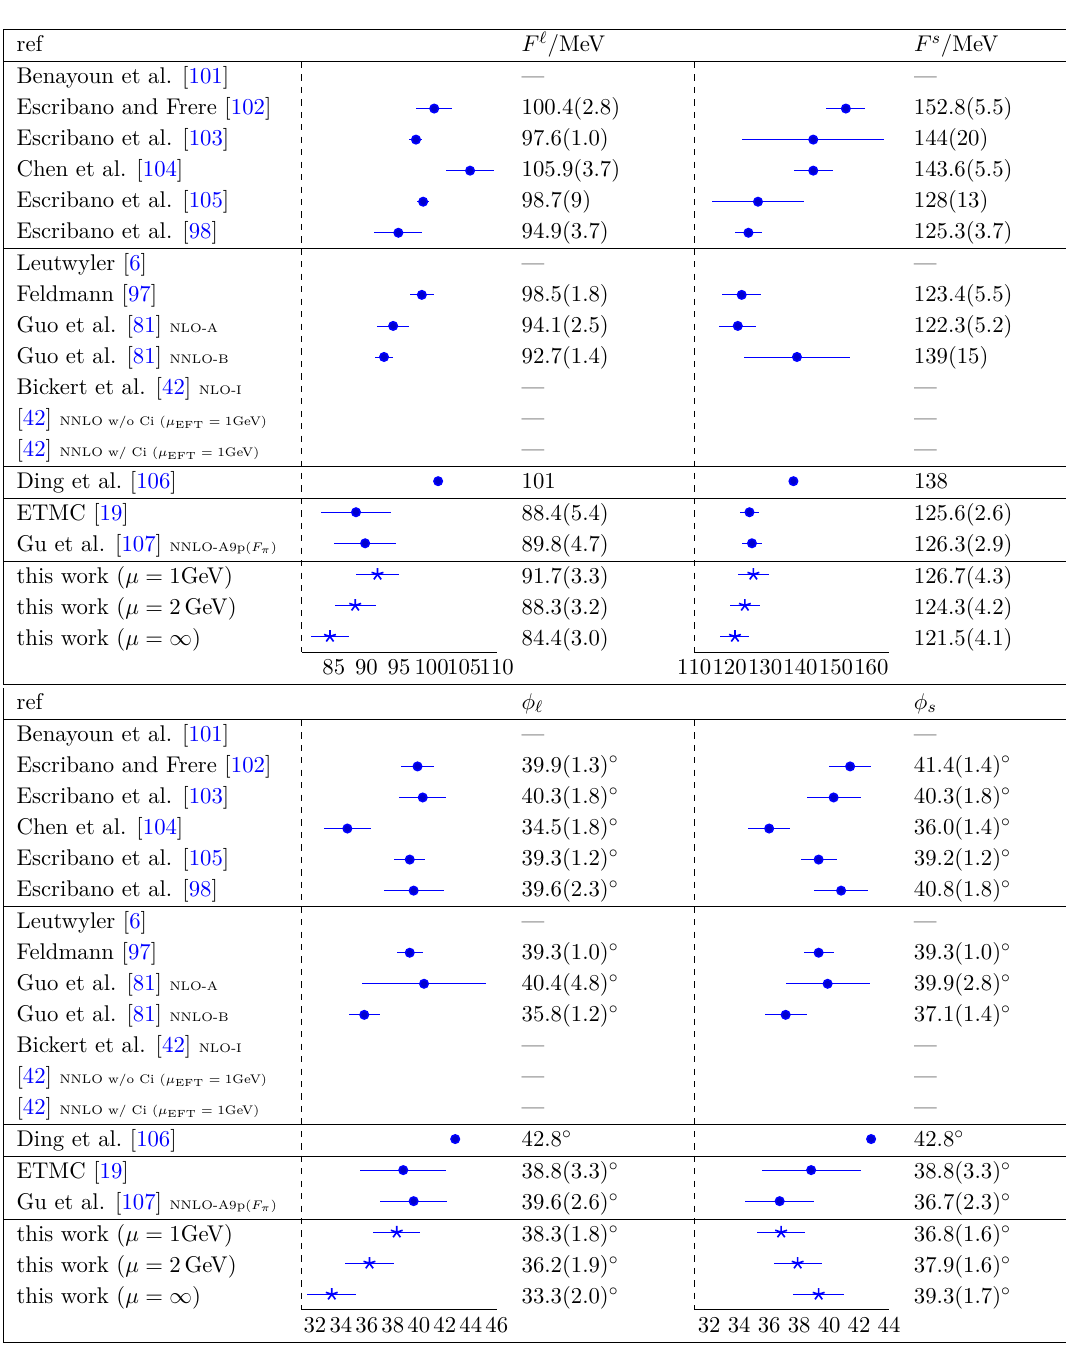
Table 16. Comparison of recent phenomenological and lattice results for the (scale dependent) decay constants in the angle representation for the light/strange flavour basis. The results from this work are presented at three different